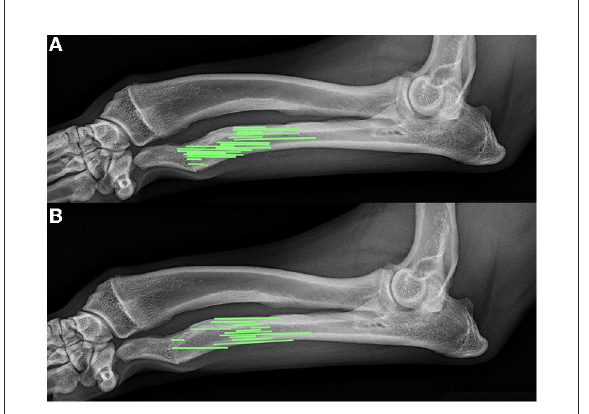
FIGURE5 Comparison of relative ostectomy sizes (based on percentage of limb length) and position in patients with (A) non-healing ostectomies and (B) healing ostectomies. This figure represents the ostectomy percentages and relative locations scaled to a single representative lateral